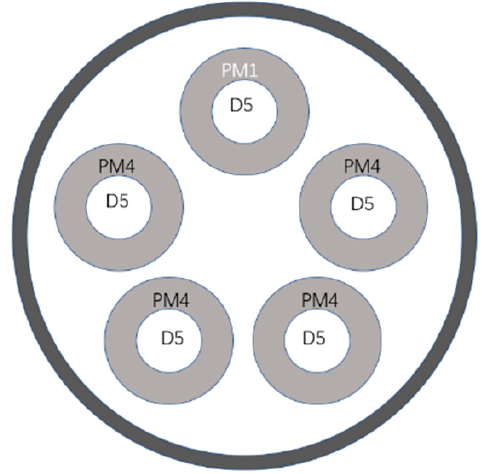
Figure 5. Combination of burner diffusion (D) and premix (PM) mode.